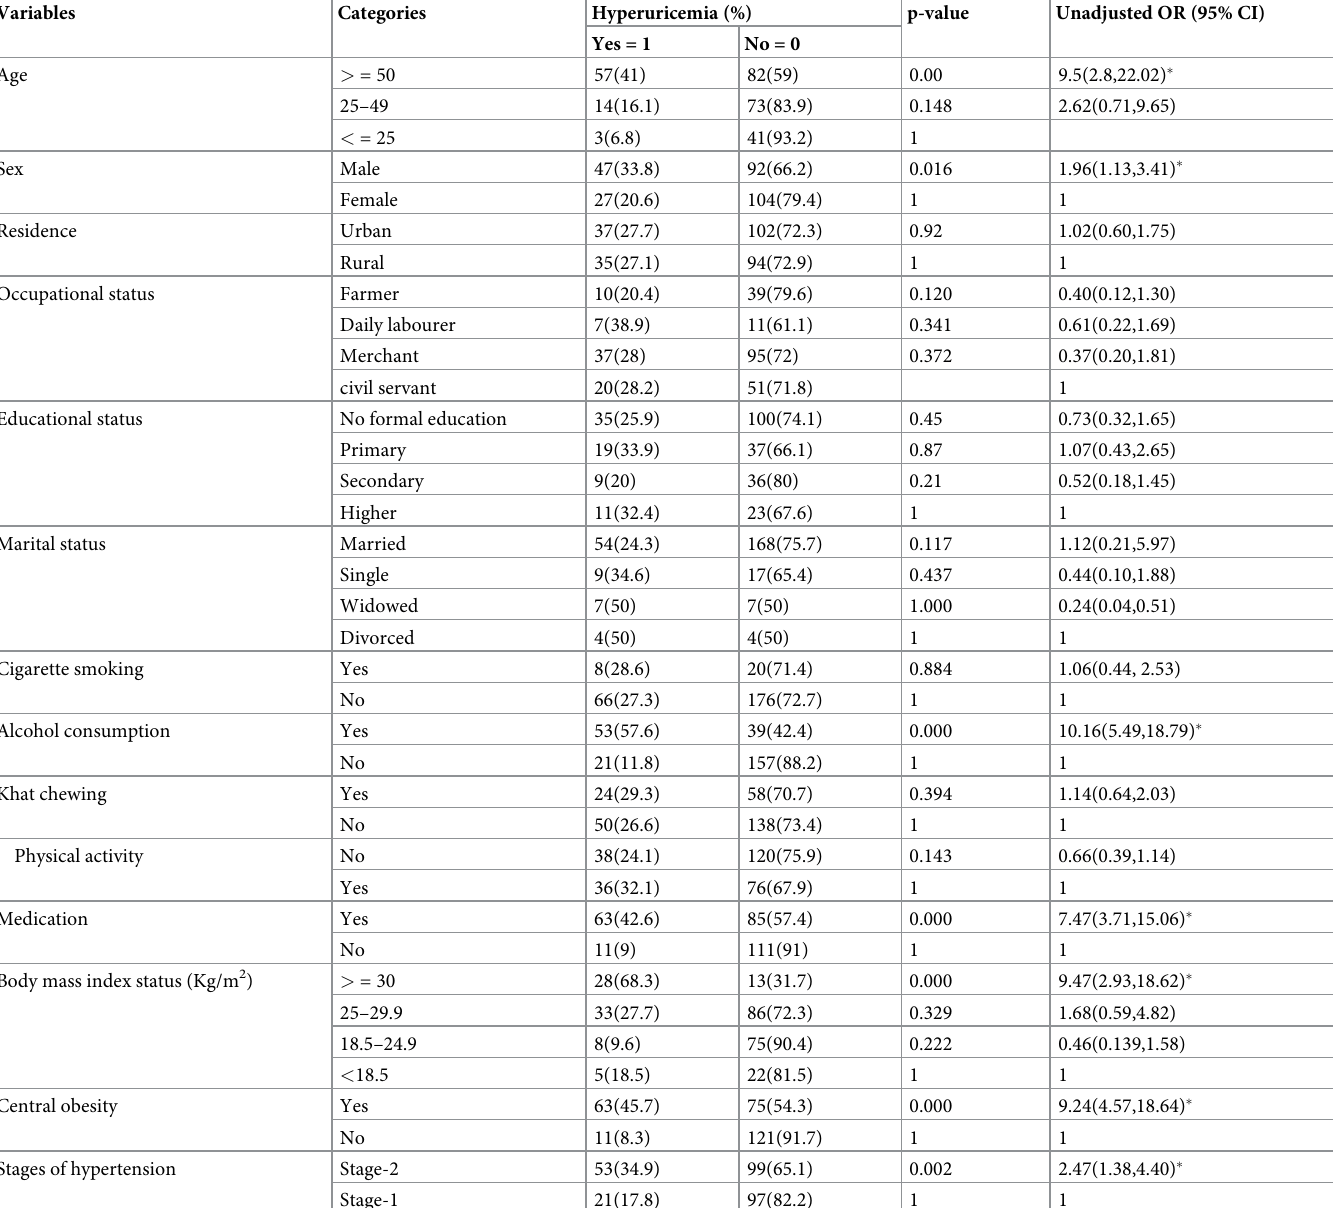
Table 3. Bivariate analysis of factors associated with hyperuricemia among essential hypertensive patients attending their follow-up at the outpatient department, in Wolkite University specialized hospital, Southern Ethiopia from November 1 to February 30, 2021.